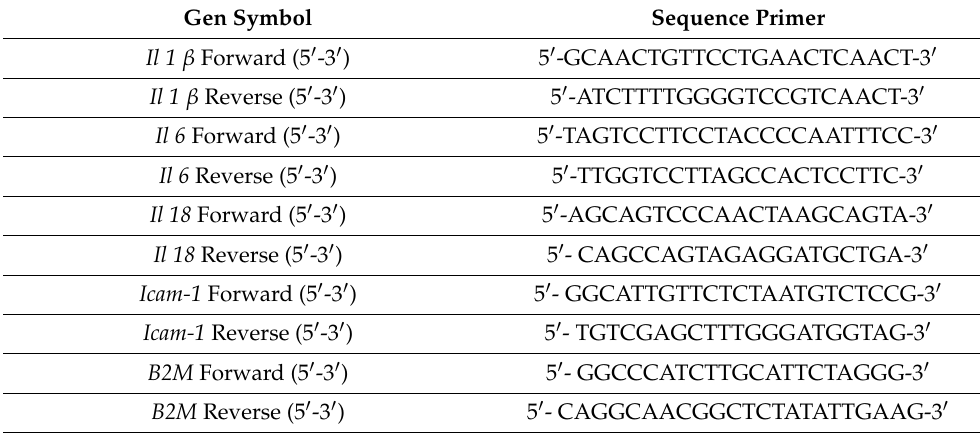
Table 1. Primers used for RT-